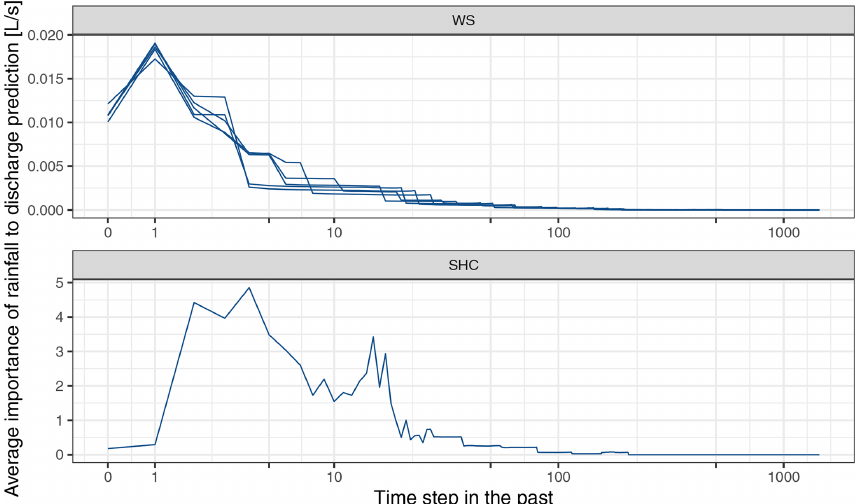
Figure 7. Average importance of the rainfall at different time steps in the past for discharge predictions in the XGBoost models of the Washington Street SuDS site (WS) and the Shayler Crossing Watershed (SHC). Each line corresponds to an XGBoost model trained on a specific training data set. Each time step is 10min. The x axis is on a pseudo-logarithmic scale. Observational SHAP values were used in the computation.